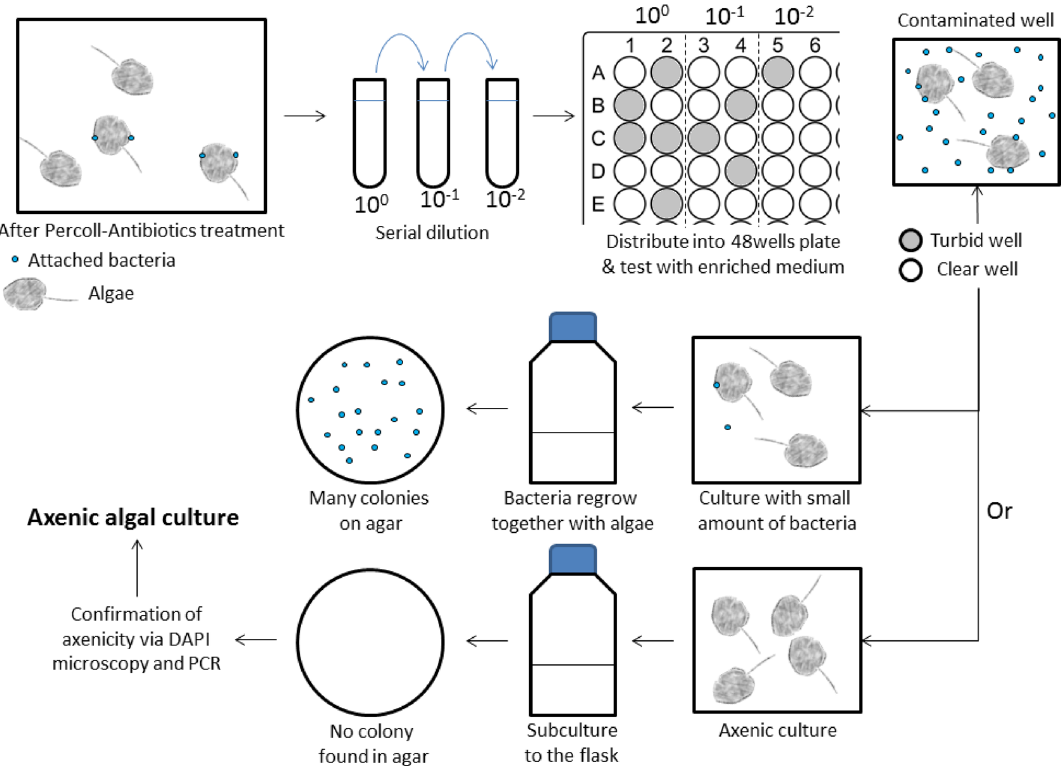
Figure 1. Selection of the axenic algal clones through serial dilution after the basic